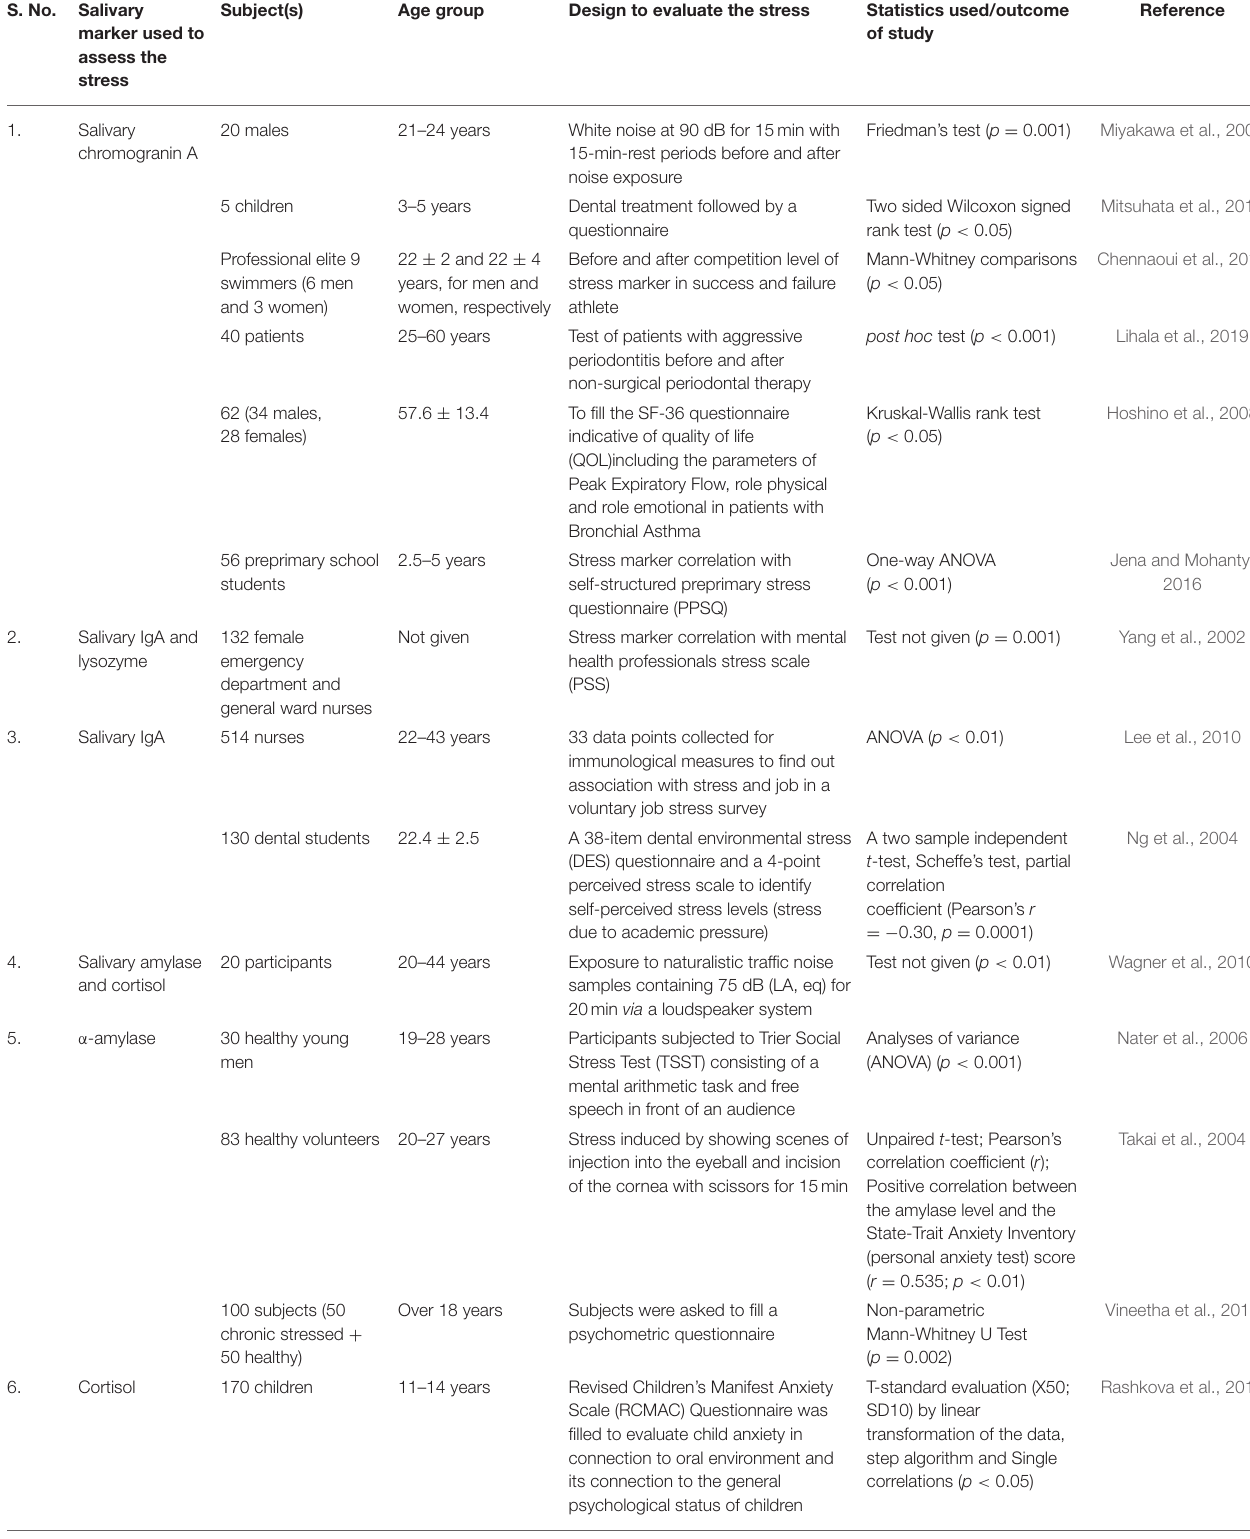
TABLE 2 | Salivary biomarkers and assessment of